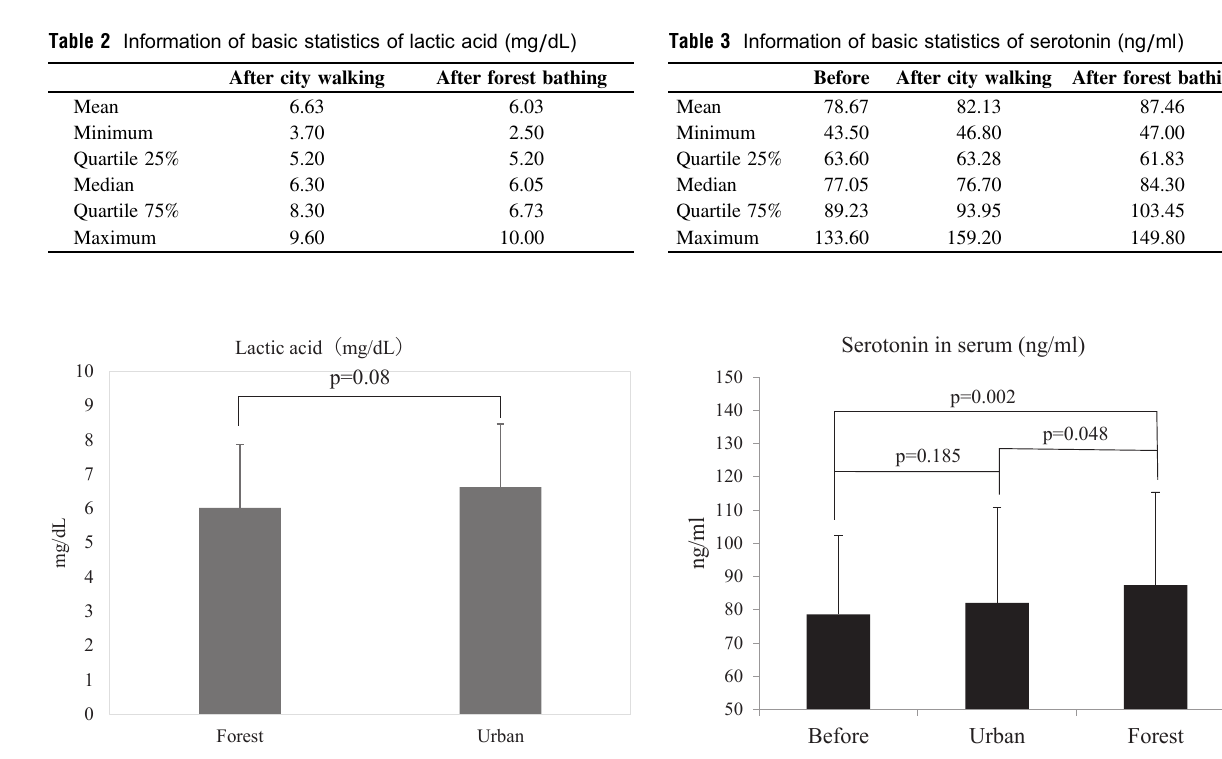
Fig. 2 Lactic acid concentrations in serum during the forest bathing and urban area walking. “ Forest ” means after walking in the forest (forest bathing) and “ Urban ” means after walking in the urban area. Data are presented with mean + SD, p = 0.08, forest vs urban by paired t-test (n = 20).